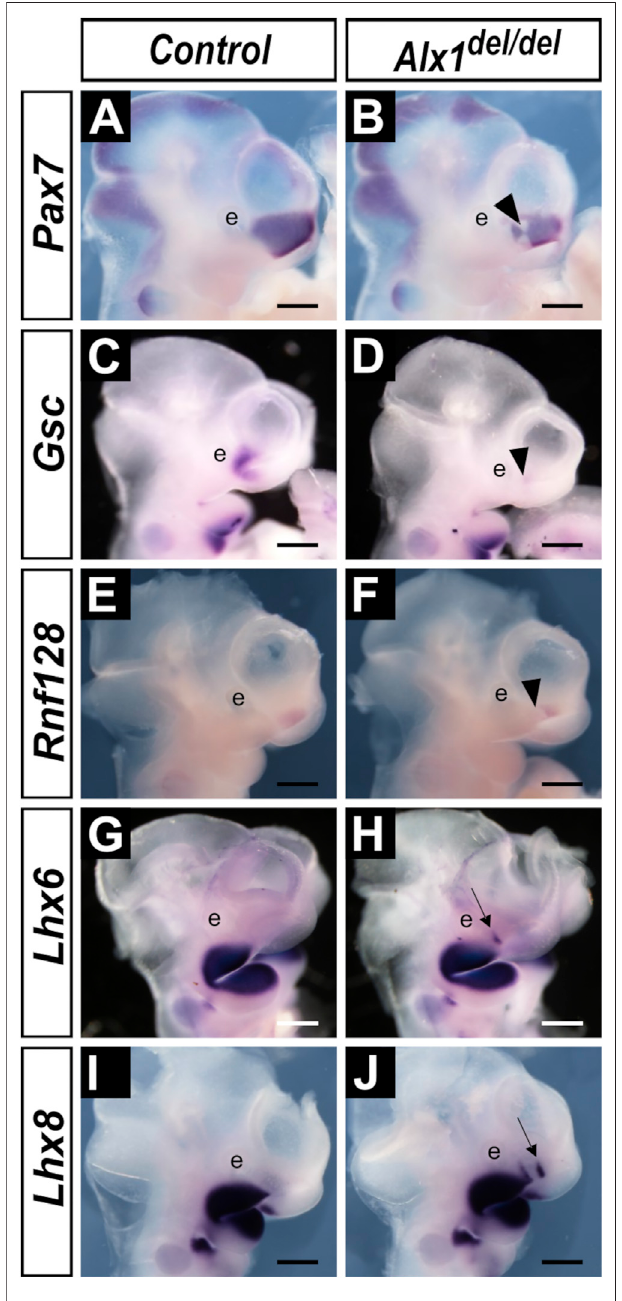
FIGURE8| Alx1 del/del embryosexhibitalteredpatternsofgeneexpressionin thedevelopinglateralnasalprocesses. (A – J) Lateralviewsofwholemountembryo heads showing patterns of expression of Pax7 (A, B) , Gsc (C, D) , Rnf128 (E, F) , Lhx6 (G,H) ,and Lhx8 (I,J) mRNAsinthecontrol (A,C,E,G,I) and Alx1 del/del (B, D, F, H, J) embryos at E10.5. Arrowhead in (B, D, F) points to the domain showing reduction and disruption of the Pax7, Gsc, and Rnf128 expression, respectively, in the Alx1 del/del embryos. Arrow in (H, J) points to the domain of ectopic Lhx6 and Lhx8 expression,respectively,inthelateralnasalprocessesinthe Alx1 del/del embryos. e, eye. Scale bars, 500 µm.